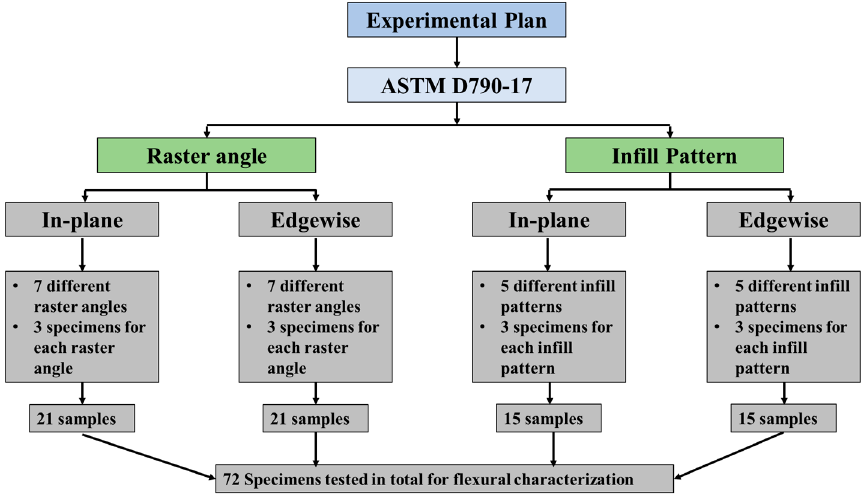
Figure 6. Experimental plan.